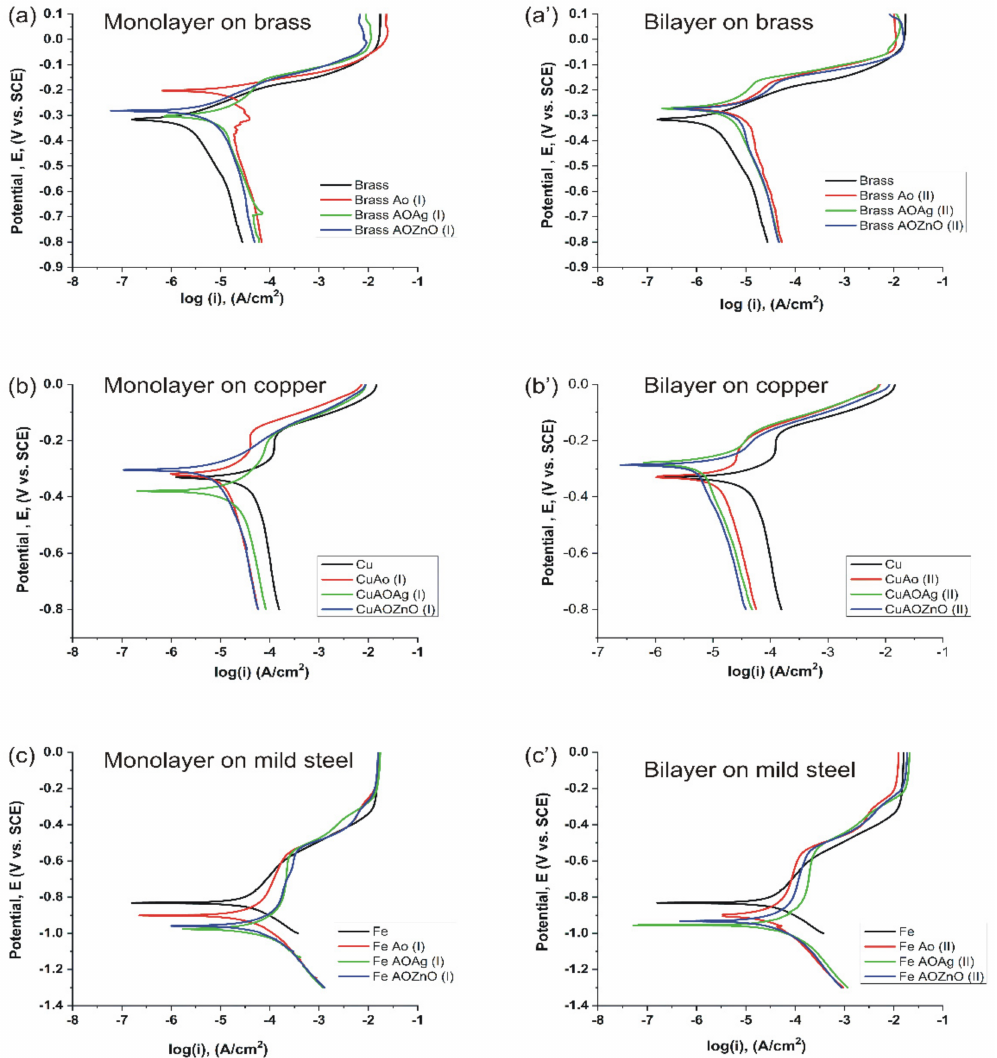
Figure 7. Potentiodynamic Tafel polarization curves of the bare and modified metallic surface in